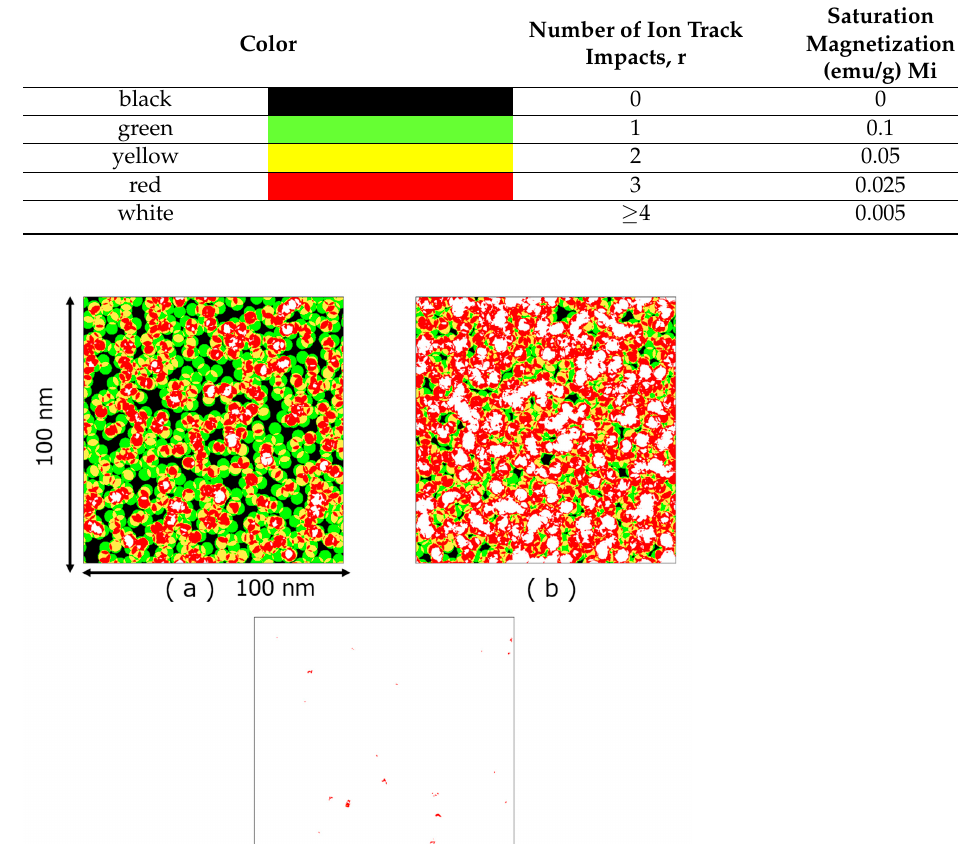
Figure 6. Two-dimensional images of irradiation-induced saturation magnetization of CeO 2 for ion fluences of ( a ) 0 cm 2 (unirradiated), and ( b ) 2.5 × 10 12 cm 2 . The diameter of ion track is assumed to be 4.7 nm. The correspondence relationship for colors and the values of magnetization is shown in Table 1. Table 1. Correspondence relationship for colors in Figures 6 and 7, the number of ion track impacts and saturation magnetization.